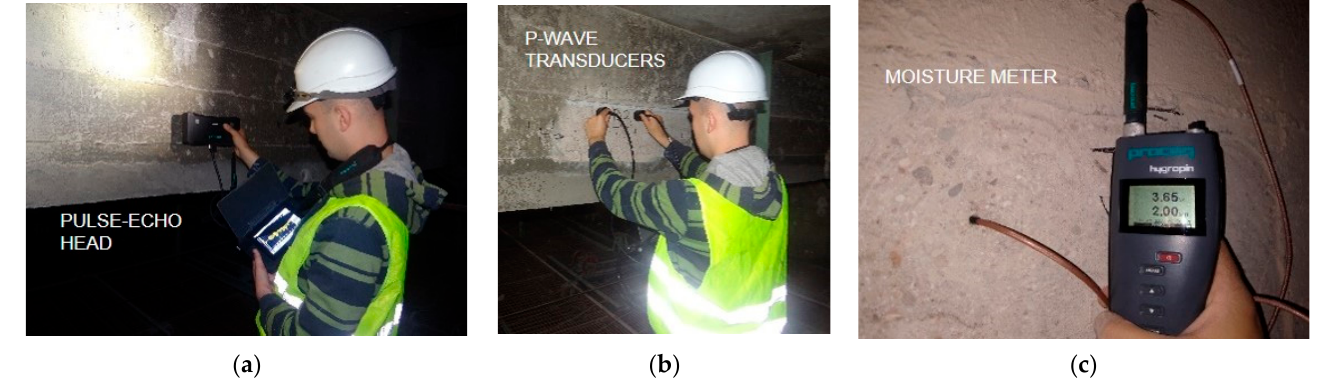
Figure 4. Non-destructive testing: ( a ) Pulse-Echo method; ( b ) ultrasonic testing using longitudinal wave transducers: ( c ) concrete moisture testing.